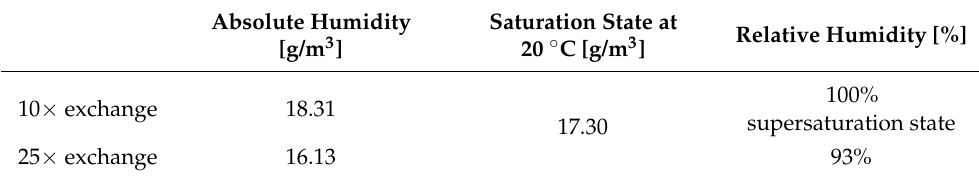
Table 4. Relative humidity in a model building depending on air exchange [58]. Absolute Humidity Saturation State [g/m 3 ]